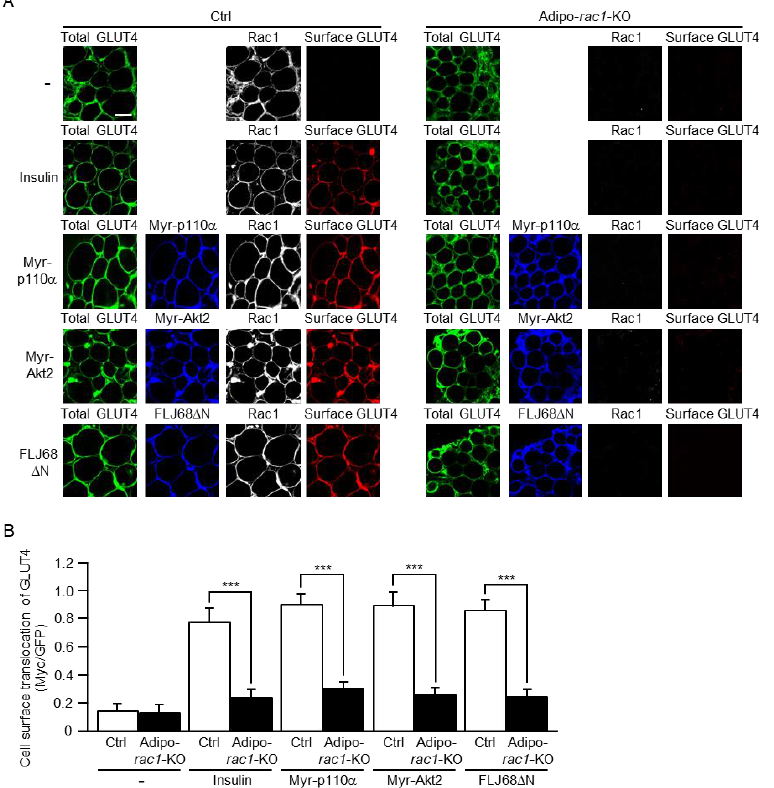
Figure 4. Inhibition of cell surface translocation of GLUT4 induced by insulin or a constitutively activated mutant of PI3K, Akt2, or FLJ00068 in rac1 -KO sWAT. ( A ) The total amount of GLUT4 myc 7-GFP was estimated by the fluorescent intensity of GFP. Myr-p110α, Myr-Akt2, and FLJ68ΔN were visualized by immunofluorescent microscopy using an anti-HA antibody. Cell surface-localized GLUT4 myc 7-GFP was visualized by immunofluorescent microscopy using an anti-Myc antibody. Scale bar, 50 μm. ( B ) Cell surface translocation of GLUT4 myc 7-GFP shown in ( A ) was quantified. Data are shown as means ± S.E. ( n = 15). *** P < 0.001.